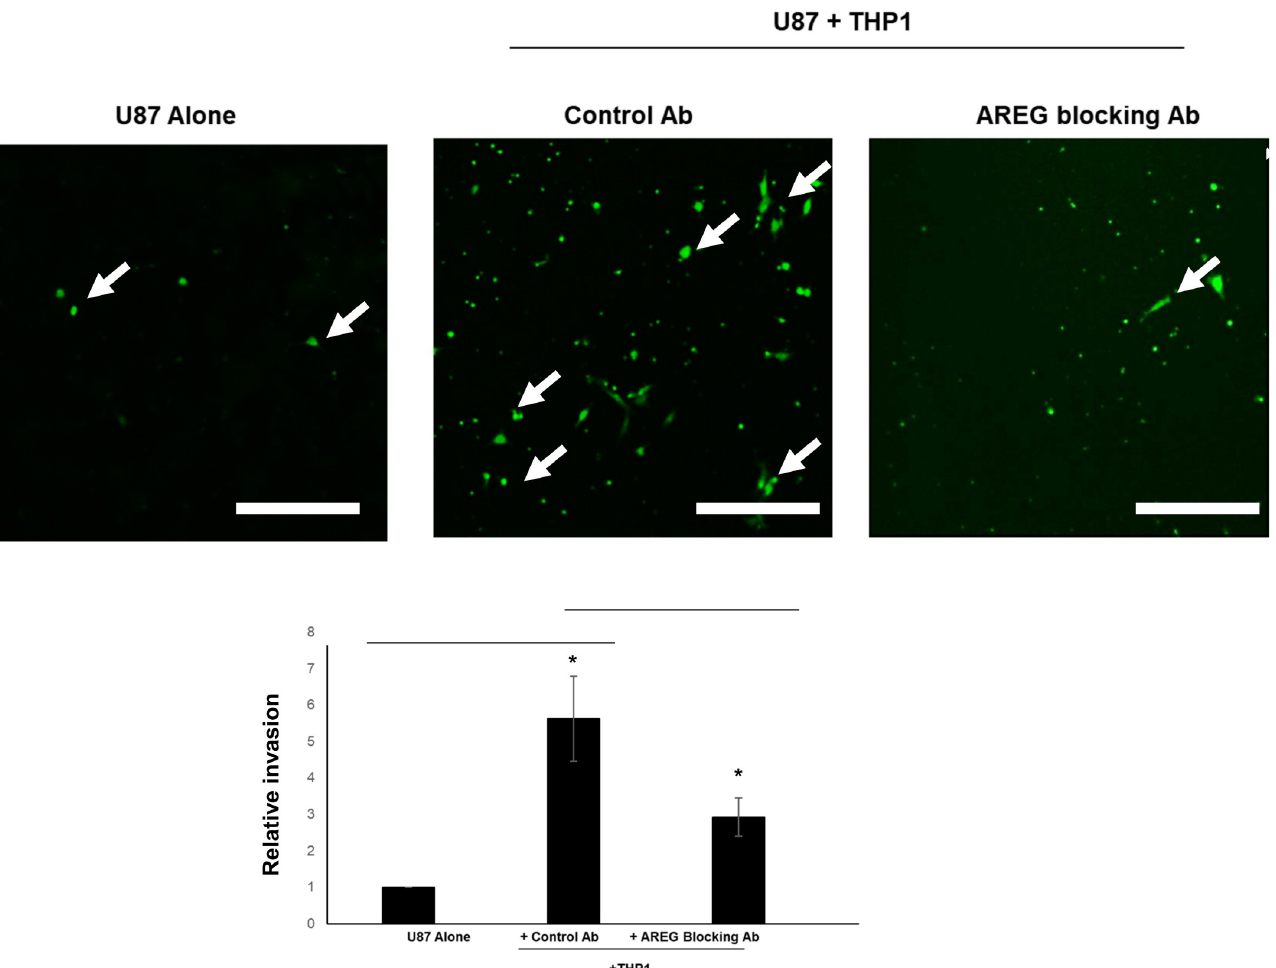
Fig 4. Blockade of AREG from THP1 macrophages during U87 glioma invasion. THP1 macrophages differentiated with PMA were cocultured with U87 cells stained with Cell Tracker Dye CMFDA (Green) on Matrigel-coated invasion with control IgG antibody or AREG blocking antibody. Representative images are shown. Arrows indicate fluorescently labeled glioma cells which have invaded to the other side of the filter. Scale bar = 200 um. Results shown are the average of at least three experiments. � : P < 0.05.